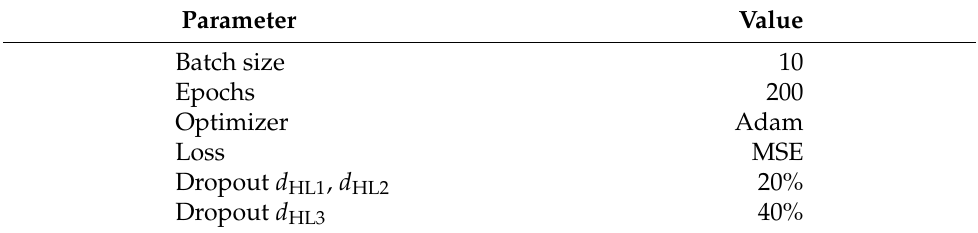
Table 2. Hyperparameters for each trained ANN.